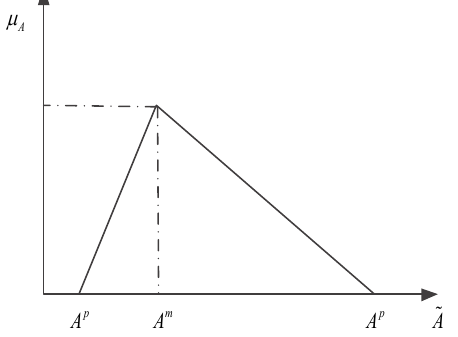
Fig. 1 . Triangular possibility distribution of the fuzzy